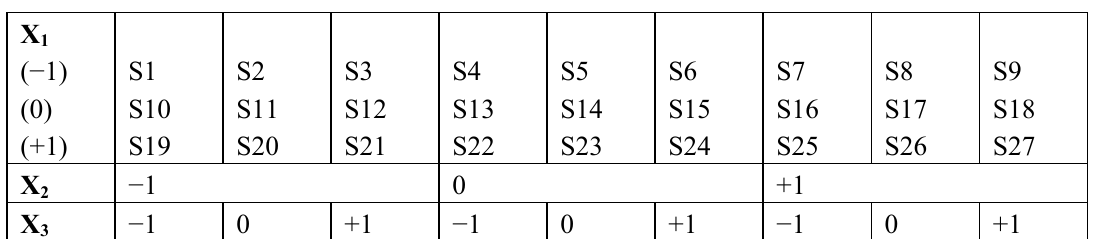
Table 3. The microsphere batches investigated in factorial